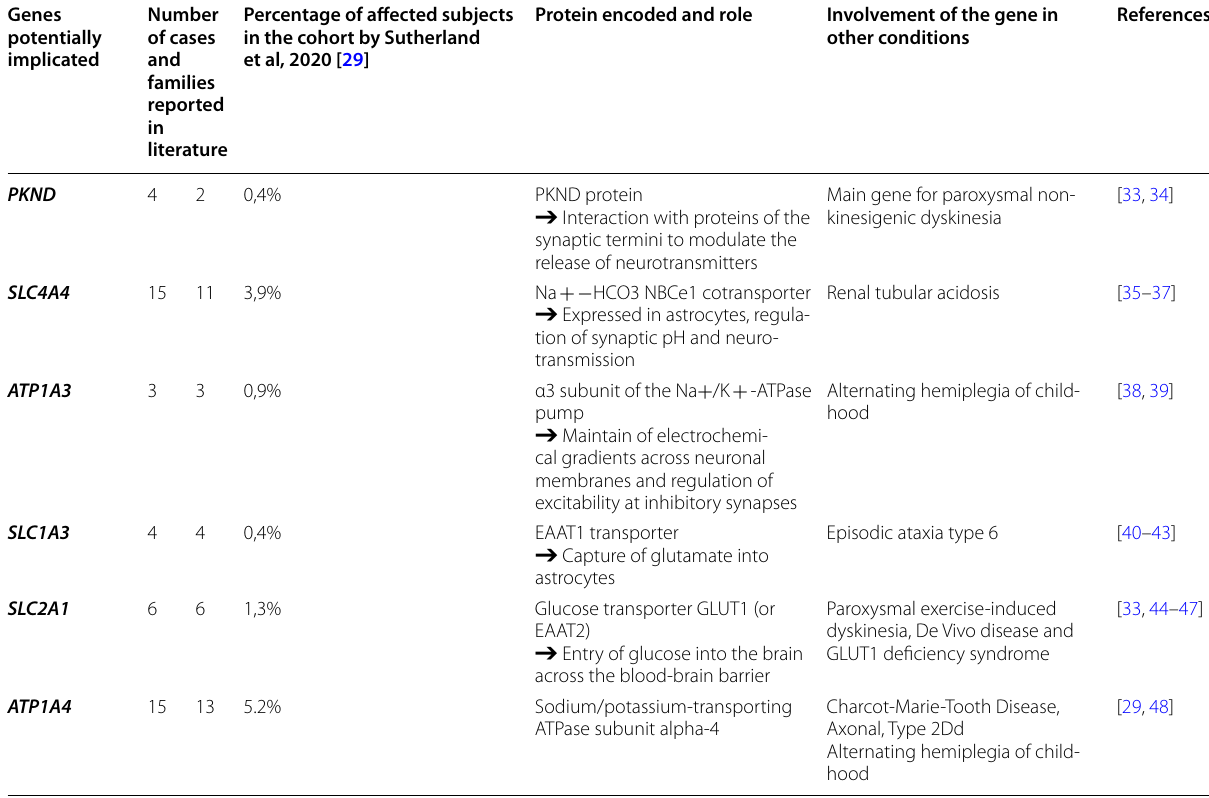
Table 2 Other genes potentially implicated in familial hemiplegic migraine (FHM) Genes